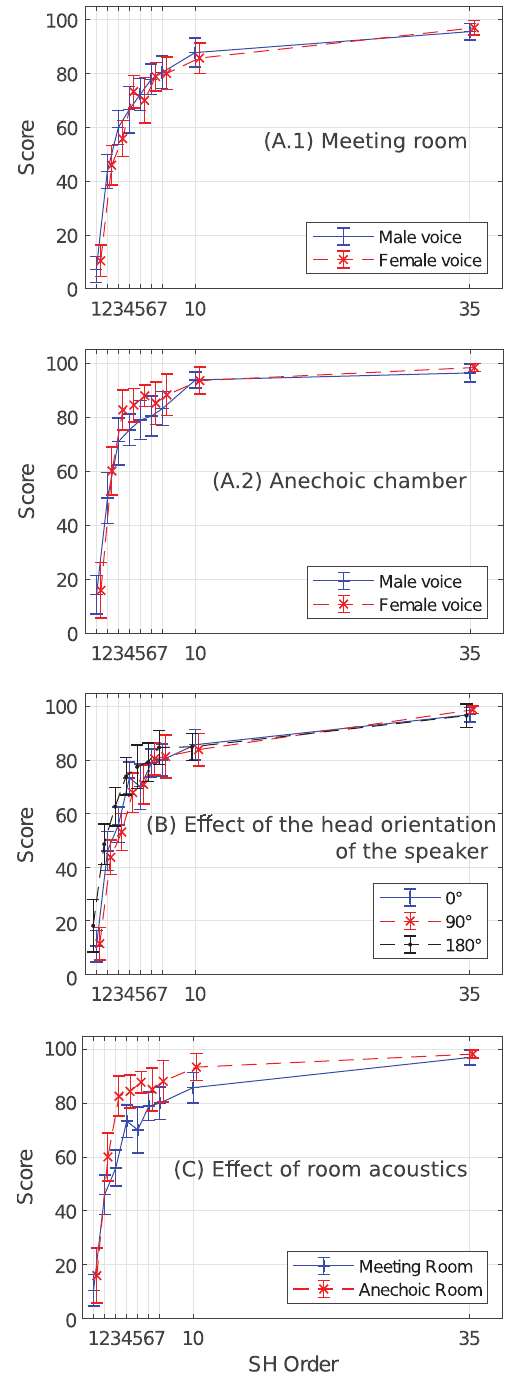
Figure 3. Average and CI 95% of the ratings for the male and female voices in (A.1) slightly reverberant and (A.2) anechoic rooms when the speaker faces the listener, (B) different head orientations, and (C) in different rooms for the female